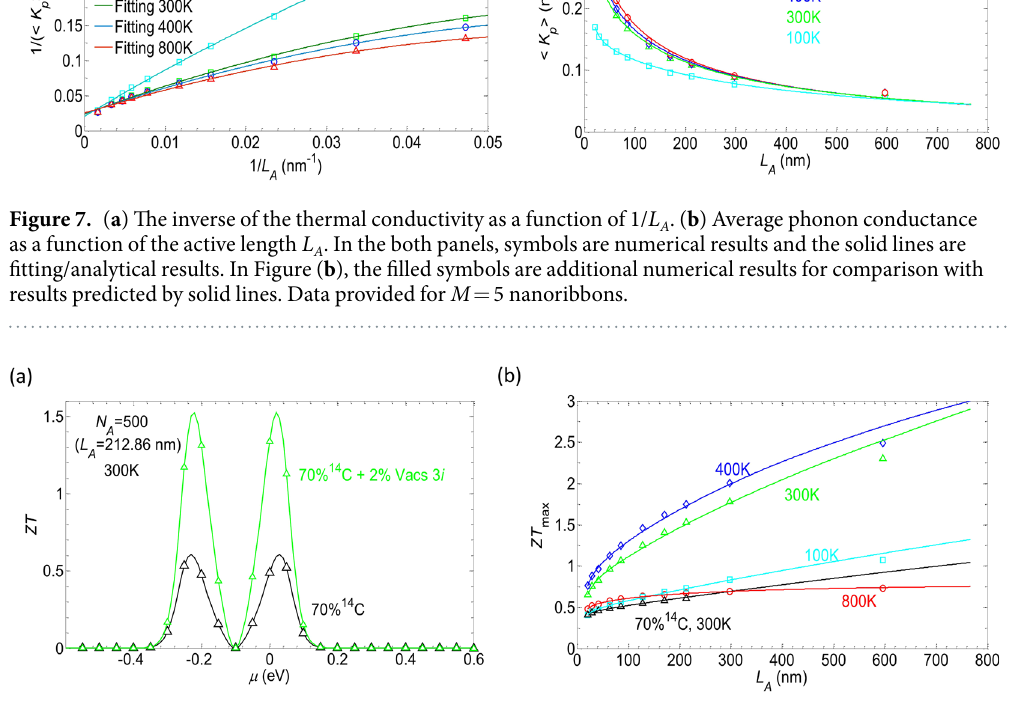
2 . The numerical (open symbols) and analytical (solid) results of